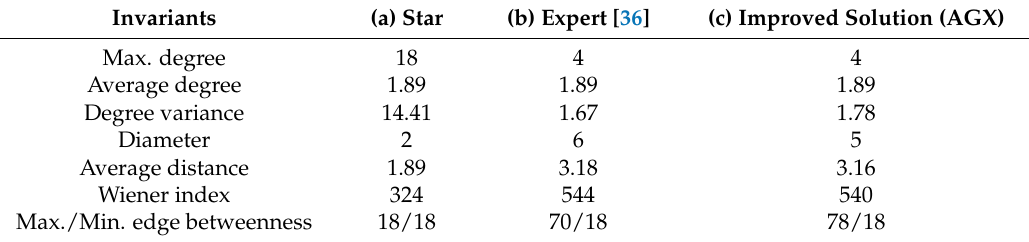
Table 2. Tree based topologies (19